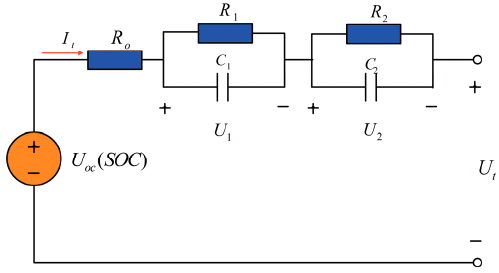
Figure 1. Schematic diagram of the second ‐ order resistor ‐ capacitor (RC) equivalent circuit model.